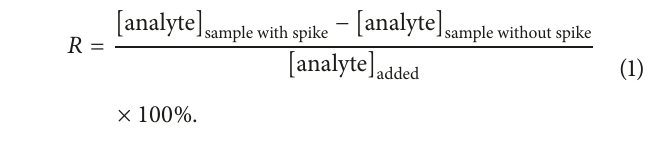
Dikma ProElut C 18 and Dikma ProElut PLS column